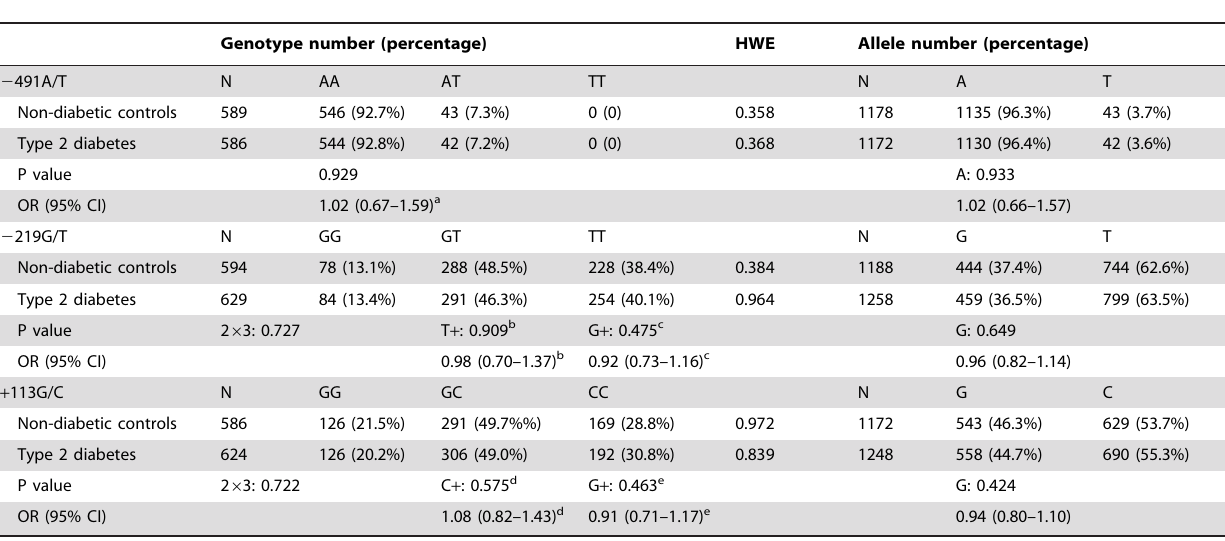
Table 1. Associations between APOE polymorphisms and the risk of type 2